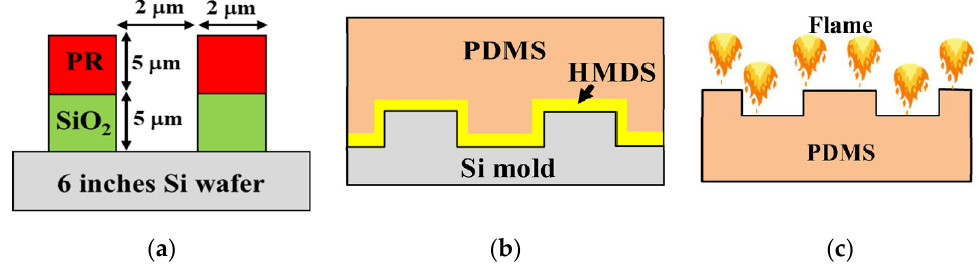
Figure 3. Cross-sectional schematic diagram (not to scale) of ( a ) PR/SiO 2 /Si patterning by conven- tional lithography and plasma etching process; ( b ) HMDS priming and PDMS casting on silicon master mold by soft lithography process; ( c ) simple flame treatment on PDMS.